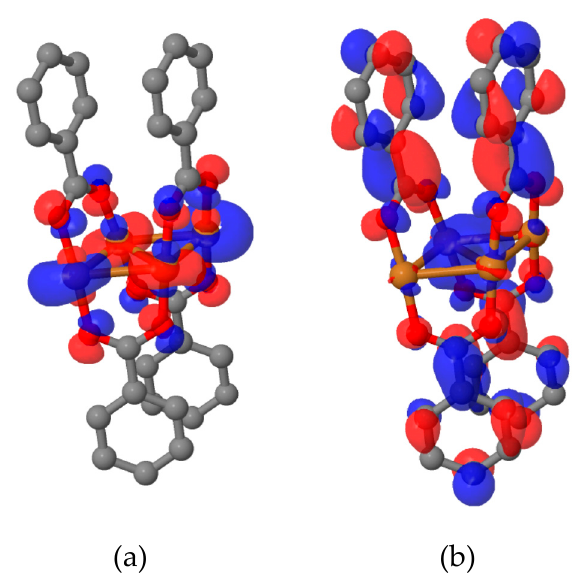
Figure 6. Frontier molecular orbitals of the Cu 4 complex (isosurfaces drawn at ± 0.04 a.u.; blue − positive; red − negative) obtained at the CAM-B3LYP/cc-pVDZ level of theory: ( a ) HOMO, ( b )